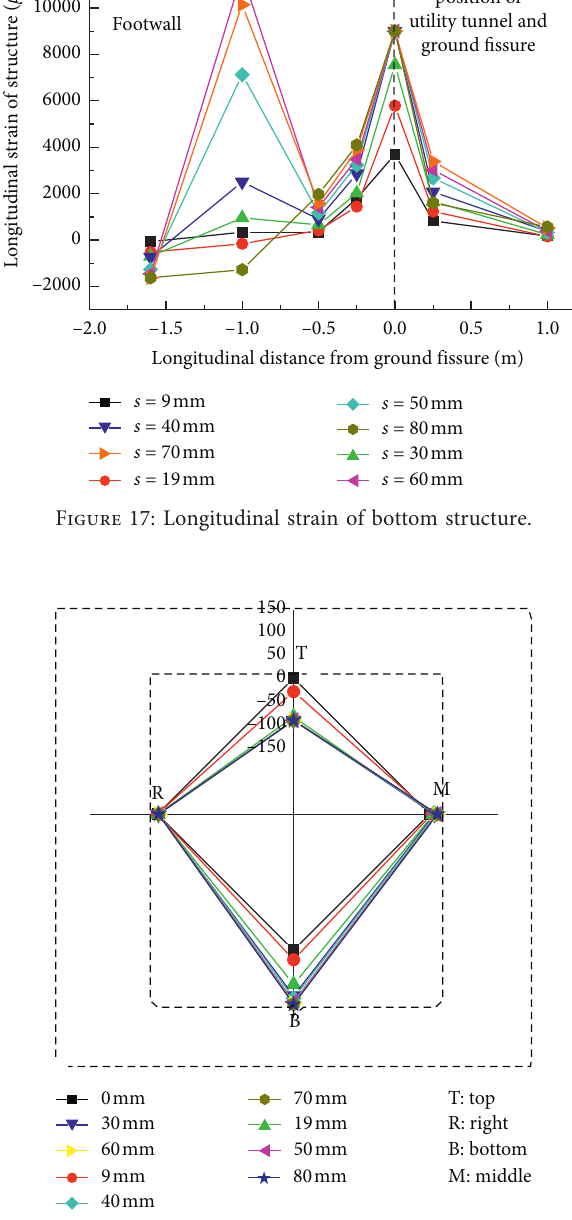
Figure 18: Hanging wall cross-sectional cabin 1 displacement.